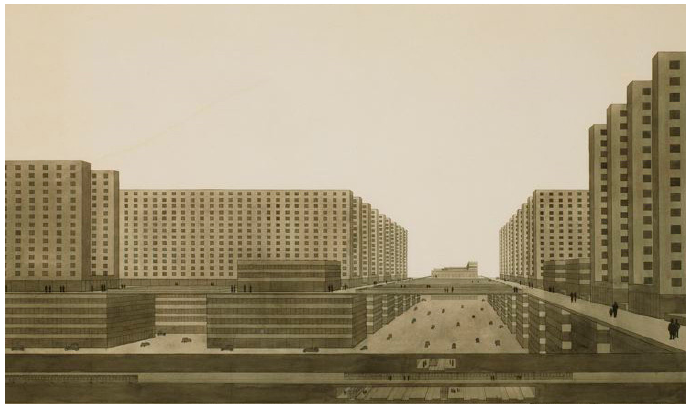
Figure 4. View of the high-rise city project by Ludwig Hilberseimer, 1924 [11] (p. 176). Globalized concrete façades without any notion of cultural memory and regional identity.